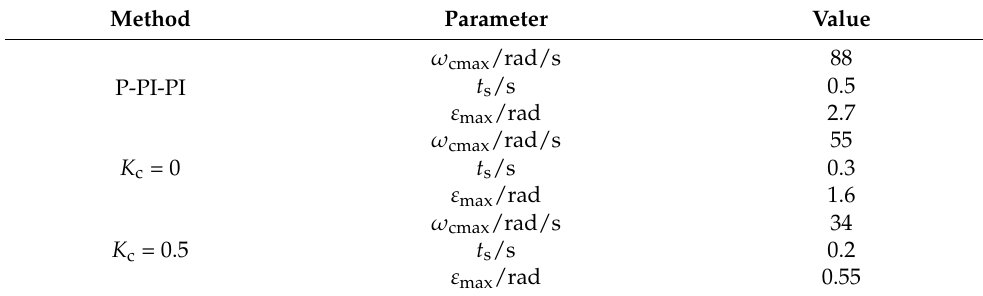
Table 2. Compared results.